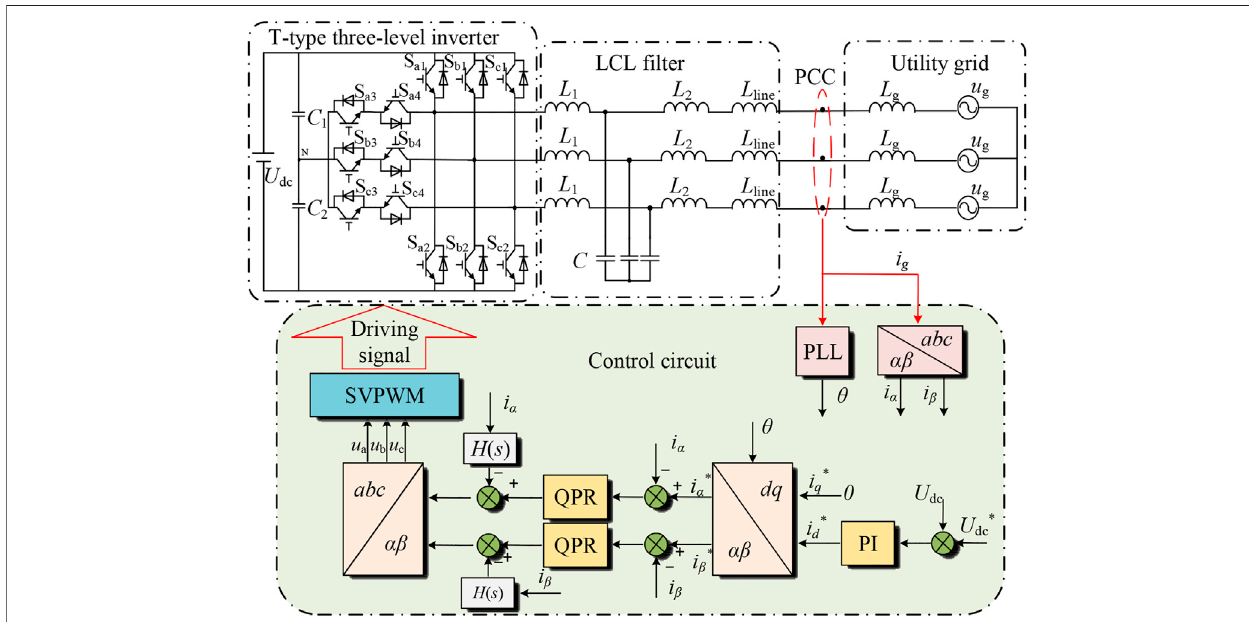
FIGURE 1 | Typical structure of the grid-connected inverter.